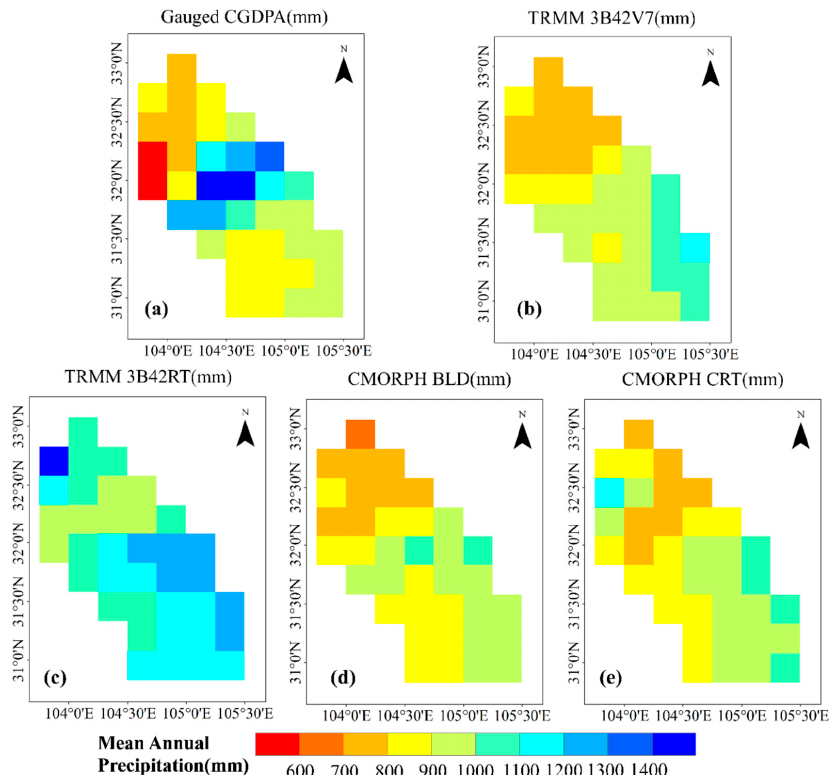
Figure 2. Spatial maps of mean annual precipitation over Fujiang River basin for the period of 2006– 2013, from ( a ) gauge observations, ( b ) TRMM 3B42V7, ( c ) TRMM 3B42RT, ( d ) CMORPH BLD and ( e ) CMORPH CRT.